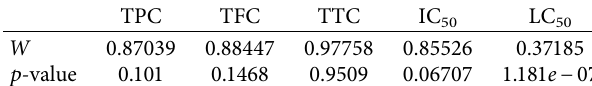
Table 7: Shapiro-Wilk test for normality.